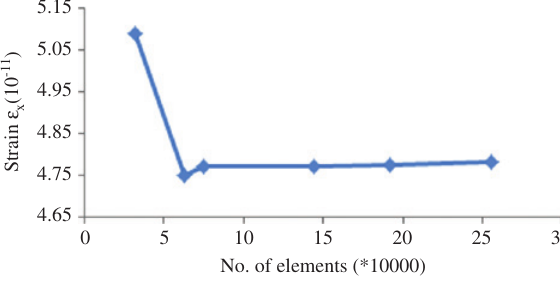
Figure 15: Change in deformation with respect to mesh